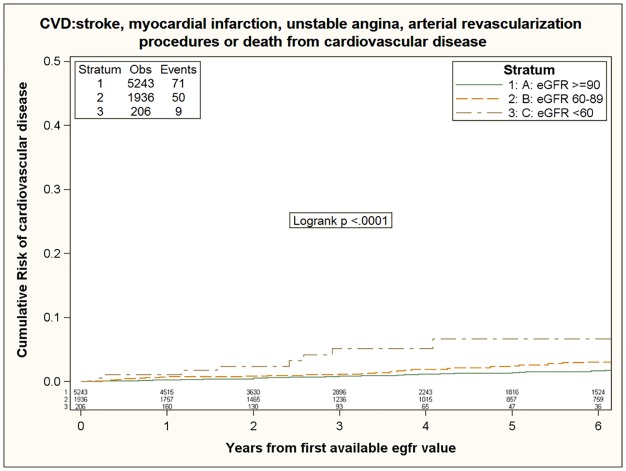
Risk of cerebro-cardiovascular disease during follow-up according to basal eGFR.